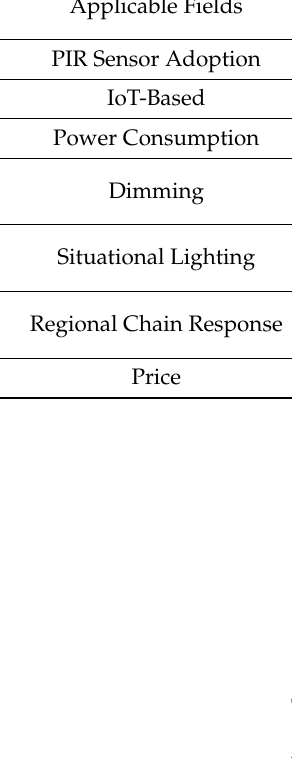
Table 3. The difference comparison between this work and